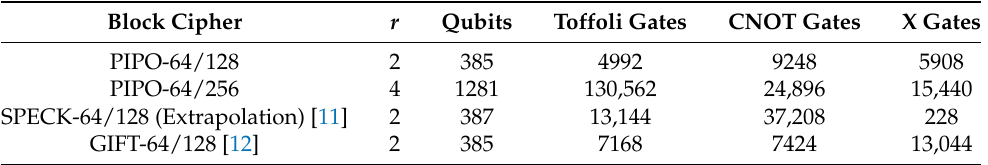
Table 3. Quantum resources for applying PIPO block cipher to the oracle of the Grover’s search